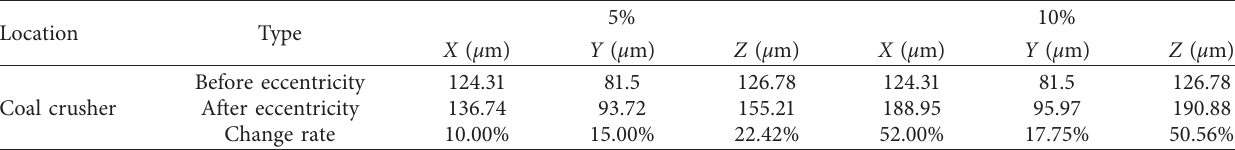
Table 11: Influence of eccentric positions of spring vibration isolators.